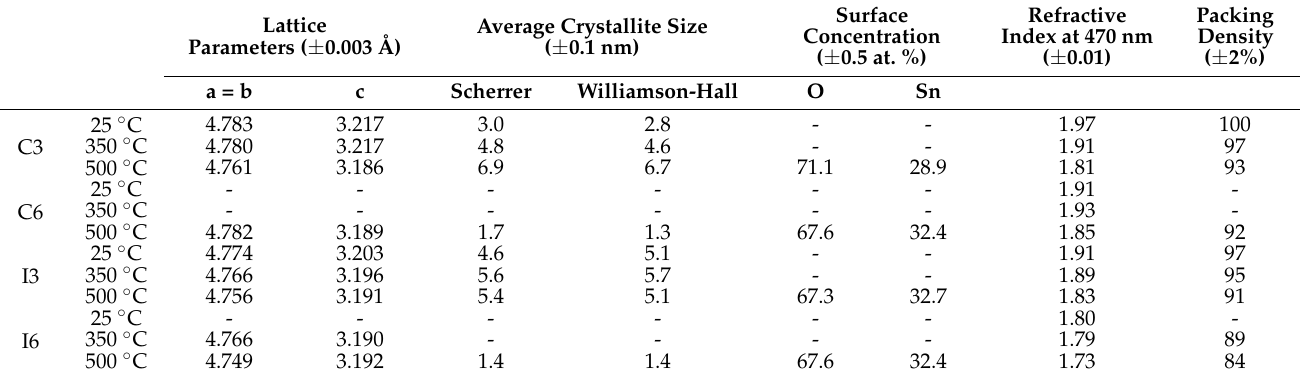
Table 1. Crystallographic properties, surface chemical composition, and porosity data of SnO 2 thin